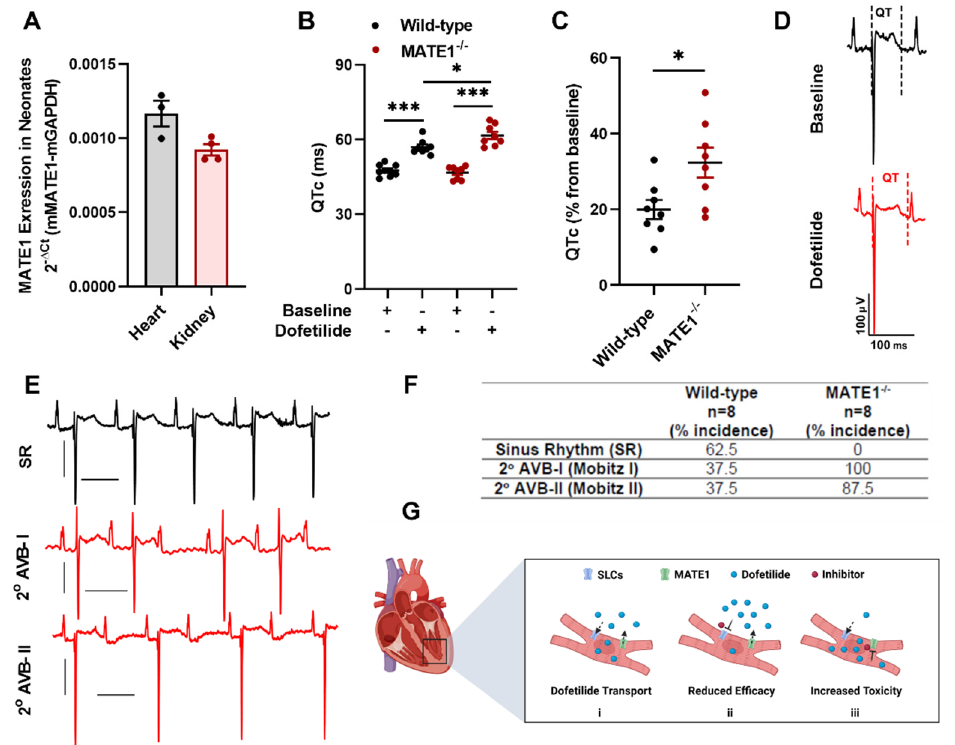
Figure 2. MATE1 deficiency exacerbates dofetilide-induced proarrhythmia. ( A ) Expression of the MATE1 gene in heart (n = 3) and kidneys (n = 4) isolated from untreated neonatal wild-type mice (day 1). ( B ) QTc interval and ( C ) percent QTc interval changes in neonatal wild-type or MATE1-deficient mice (day one) 15 min after a single i.p. injection of dofetilide at a dose of 0.5 mg/kg (n = 8 per group). All experimental values are presented as mean ± SEM. Statistical analysis was performed using an unpaired two-sided Student’s t test with Welch’s correction: * p < 0.05, *** p < 0.001, compared to baseline values. ( D ) In vivo surface ECG illustrating changes in QTc after dofetilide treatment in neonatal wild-type mice. ( E ) Dofetilide-induced second-degree AV blocks in neonatal MATE1-deficient mice. ( F ) Incidence of second-degree AV blocks (Mobitz I and Mobitz II) in neonatal wild-type and MATE1-deficient mice (n = 8 per group) after treatment with dofetilide. ( G ) Schematic diagram illustrating the proposed MATE1-dependent regulation of dofetilide transport (i) as a modulator of accumulation in cardiac myocytes leading to reduced (ii) or increased (iii) intracellular concentrations and reduced or increased electrophysiologic activity.